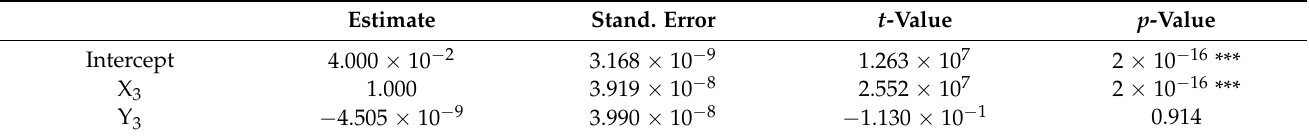
Table 4. Coefficients of MLRM for the experimentally fixed rate constant at 420 ◦ C with a difference of 0.04. Where ‘***’ shows a statistically significant value. Estimate Stand. Error t -Value p